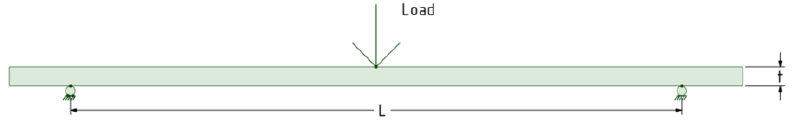
Figure 1. Three-point bending test diagram. Table 1. ASTM D7264 parameters used in finite-element model.